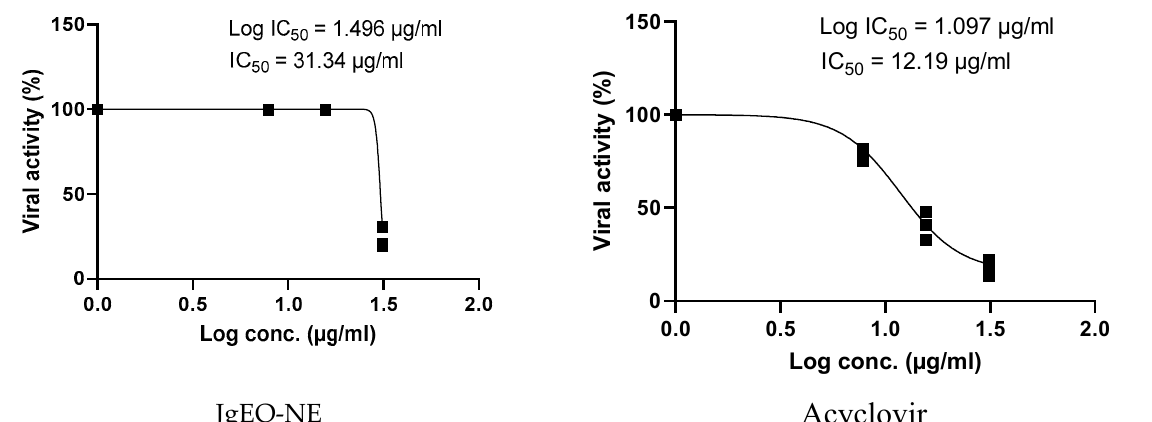
Figure 6. IC 50 of J. humile (JhEO) and J. grandiflorum (JgEO) pure essential oils, their nanoemulsion formulations (JhEO-NE) and (JgEO-NE), plain nanoemulsion formulation (Plain-NE) as well as standard acyclovir against HSV-1 virus.